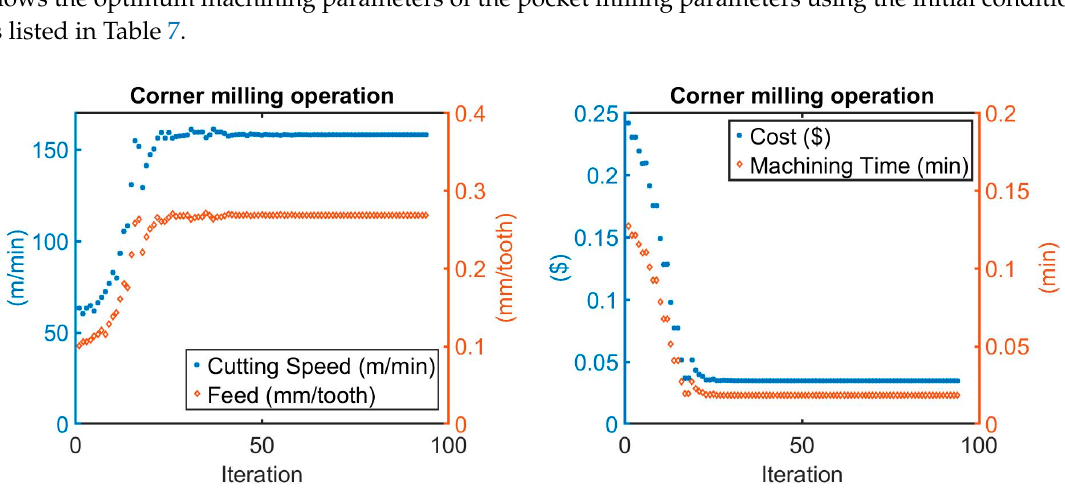
Figure 7. Machining parameters ( left ) and results ( right ) for corner operation of the case study. Table 6. Initial and optimum parameters of corner milling.